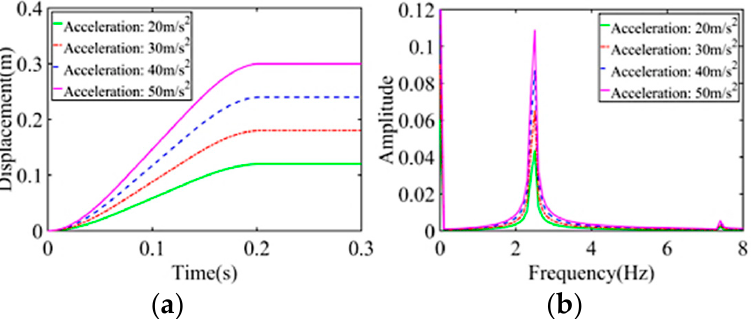
Figure 10. Calculated amplitude spectrum of different accelerations under the same acceleration time (80 ms): ( a ) displacement comparison; ( b ) amplitude spectrum comparison.